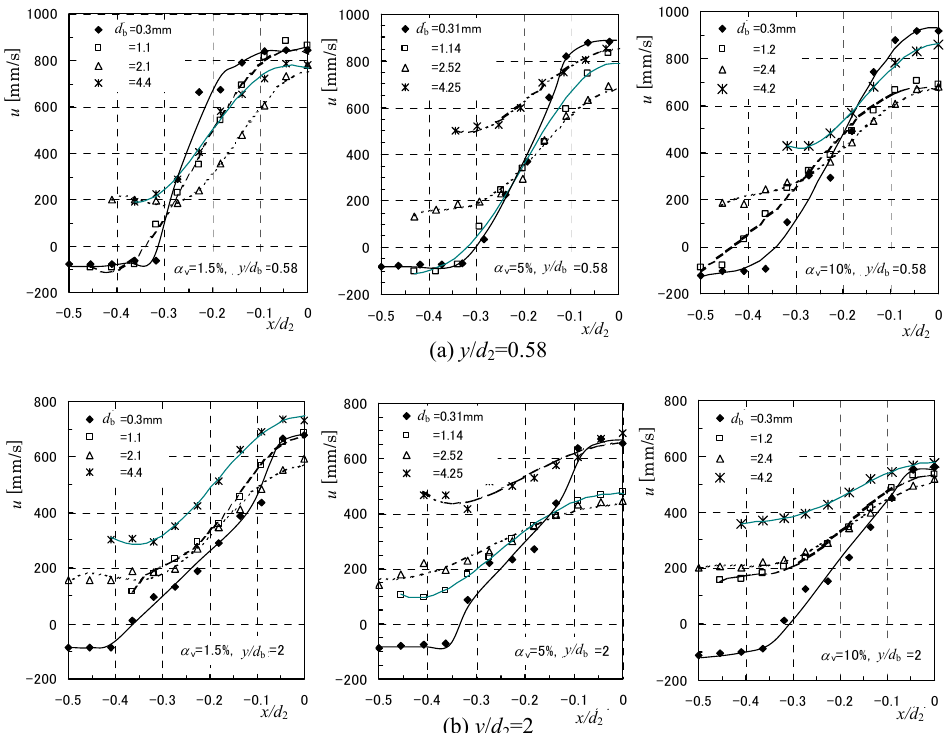
Fig.4 Velocity distribution profile and bubble size